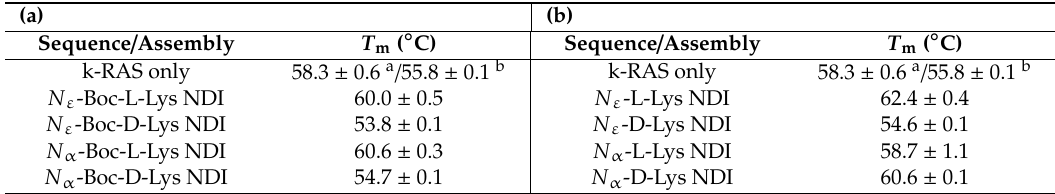
Table 3. The T m values of k-RAS only compared to the T m of ( a ) k-RAS-Boc-protected-NDIs and ( b ) k-RAS-deprotected-NDIs as determined from VT CD studies.